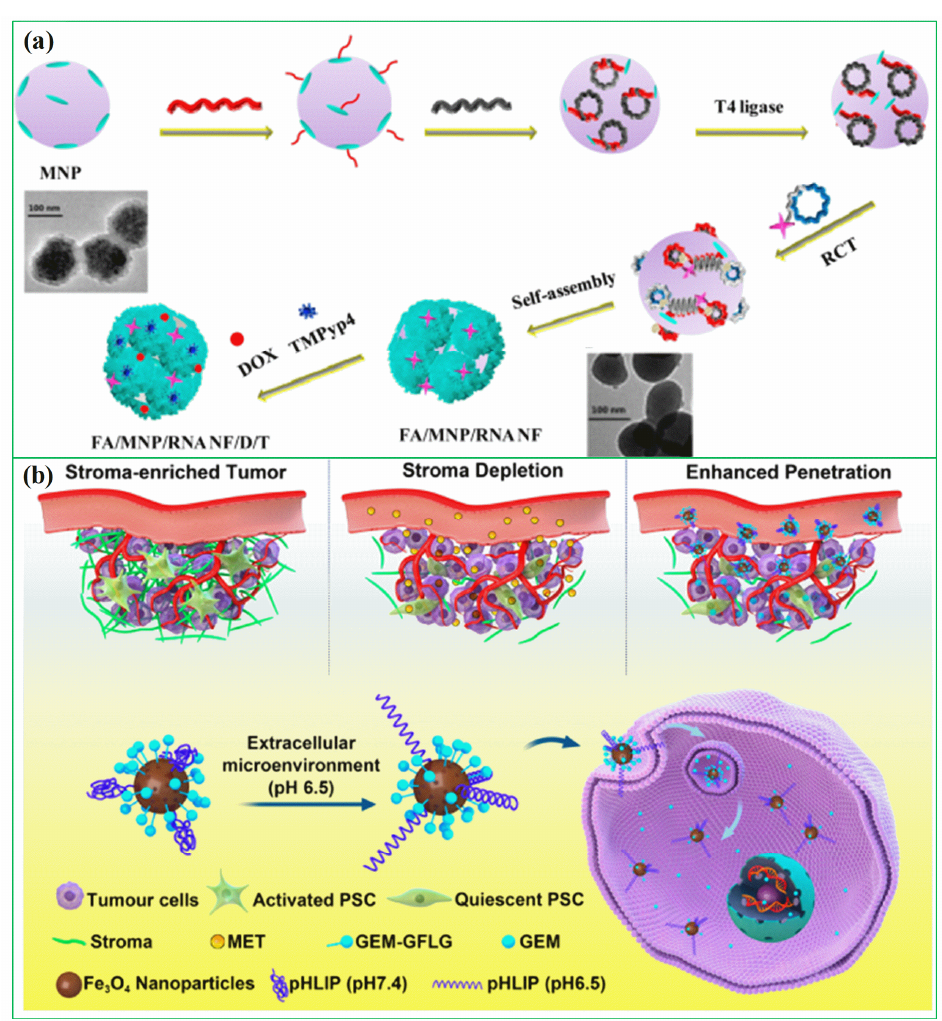
Figure 2. ( a ) Schematic diagram for the development of FA/MNP/RNA NF, reprinted from Ref.